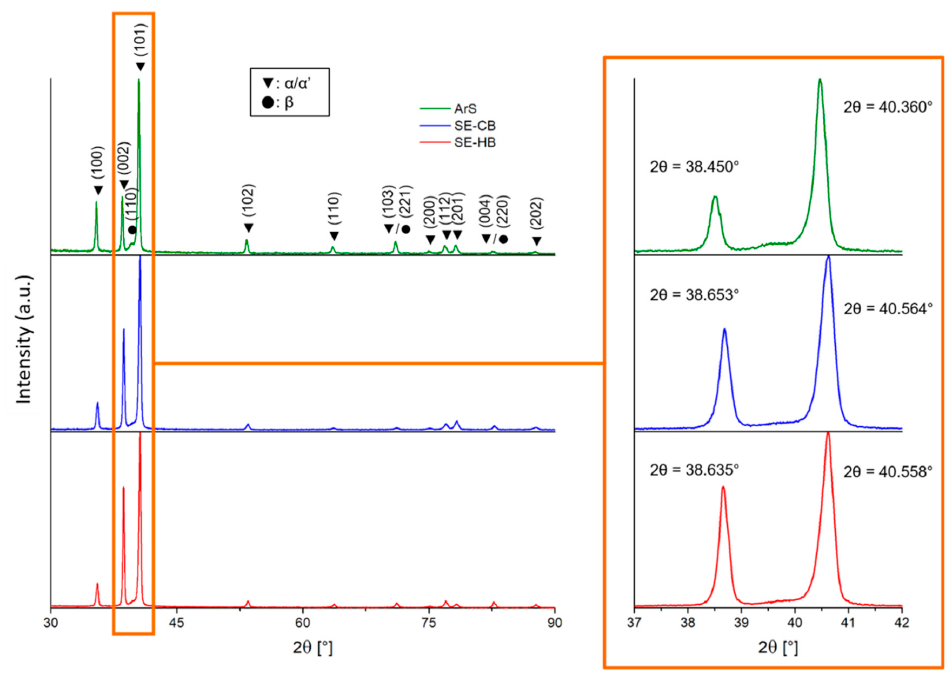
Figure 3. XRD patterns for all the deposition conditions considered.